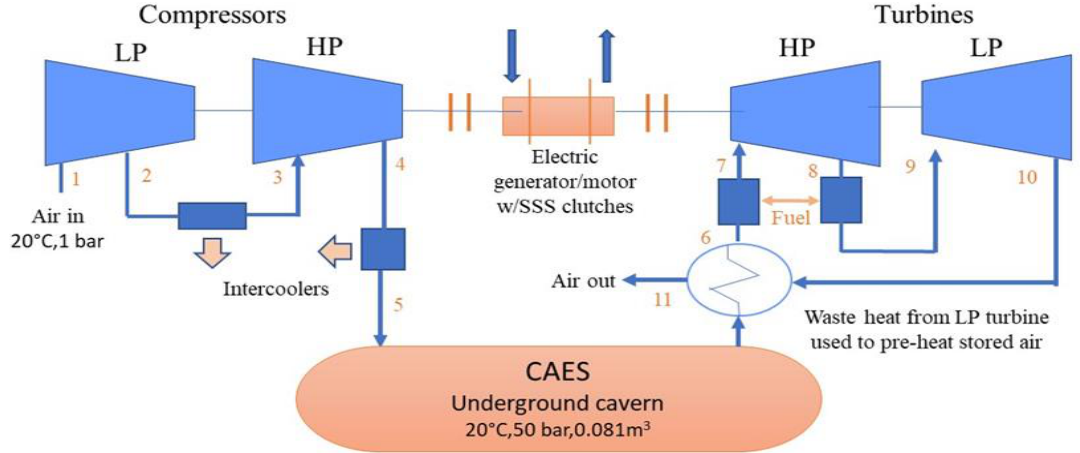
Figure 5. Heat and energy fluxes at the McIntosh CAES plant, adapted from [35].